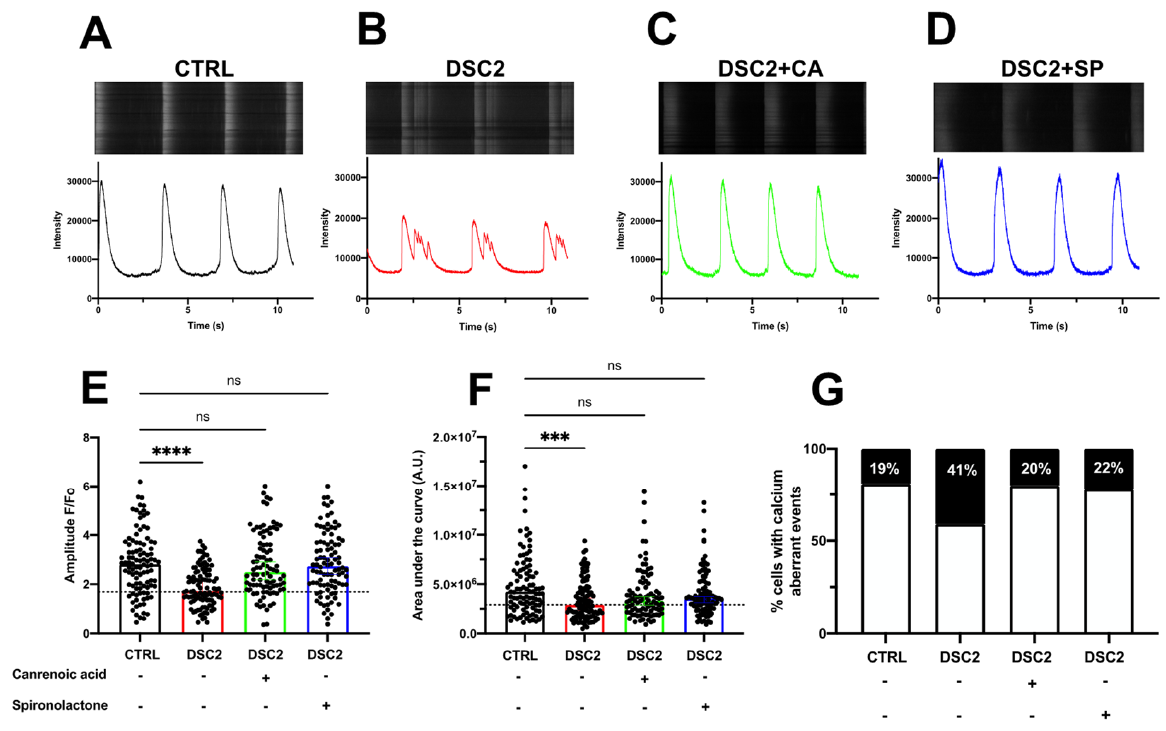
Figure 4. Effect of Canrenoic Acid on Calcium handling. Examples of spontaneous Ca 2+ transient recorded in control ( A ) (black; n = 100), DSC2 ( B ) (red; n = 101), DSC2 + CA ( C ) (green; n = 92), and DSC2 + SP ( D ) (blue; n = 94). Values of amplitude ( E , F ), the area under the curve (AUC) of Ca 2+ transients, and ( G ) percentage of cells presenting Ca 2+ aberrant events for the different conditions. Results are represented with the median and 95% confidence interval. The stars * correspond to the difference from the control. ns not statically significant, *** p < 0.001 **** p < 0.0001 (Kruskal–Wallis test).